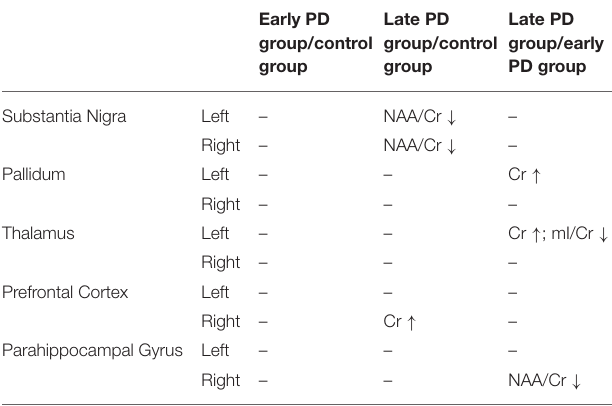
TABLE 2 | Summary of the positive MRS results shown in left/right cerebral hemisphere in the early, late PD group and the control